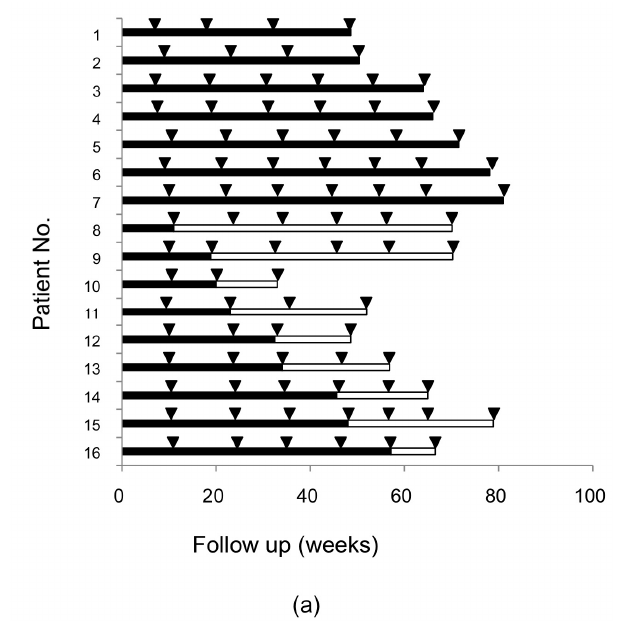
Figure 1. Cont. Figure 1.